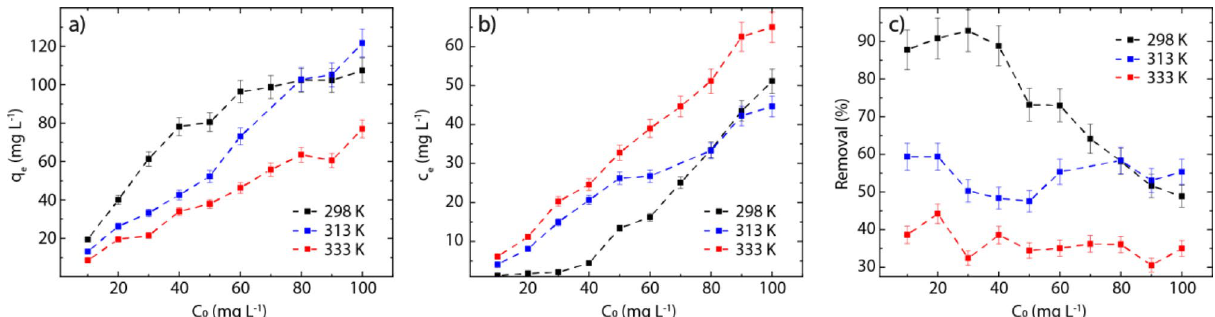
Figure 4. Effect of the initial concentration. ( a ) The adsorption capacity of rGO as a function of the initial Hg(II) concentration, ( b ) C e as a function of C 0 , and ( c ) removal percentage as a function of C 0 , considering three different temperatures (298, 313, 333